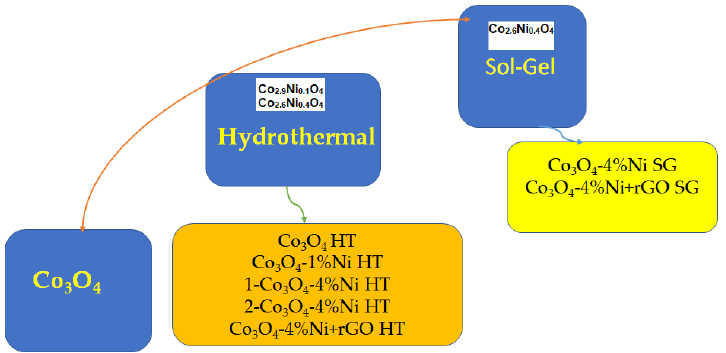
Figure 1. Scheme of the samples used in this research.